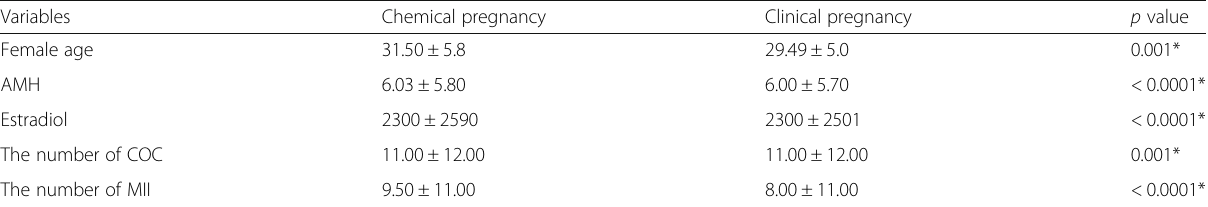
Table 2 The relationship between clinical parameters and pregnancy outcomes